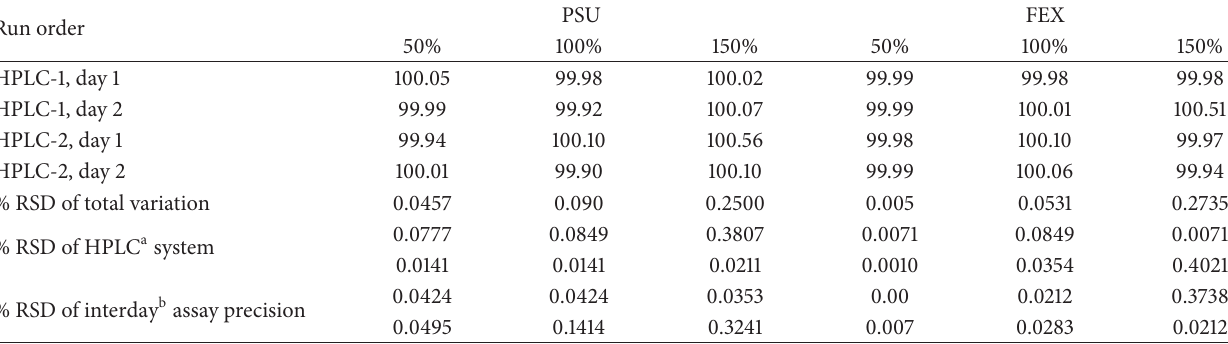
Table 6: Summary of